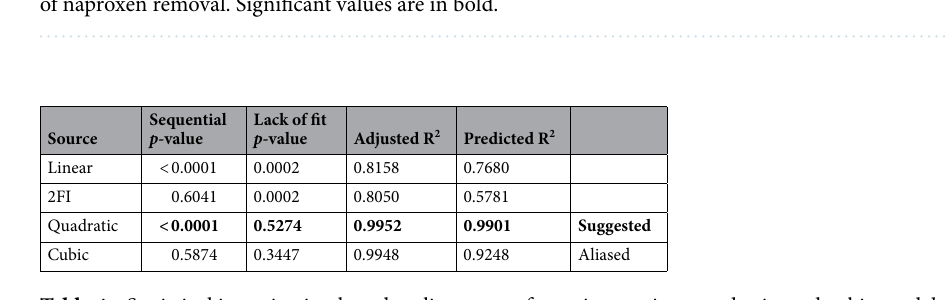
Table 4. Statistical investigation based on linear, two-factor interaction, quadratic, and cubic models. Significant values are in